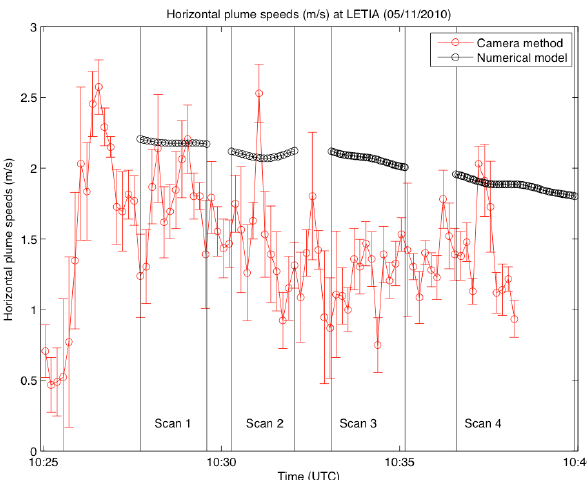
Fig. 10. Experimental (red circle) and simulated (black circle) hor- izontal plume speeds.